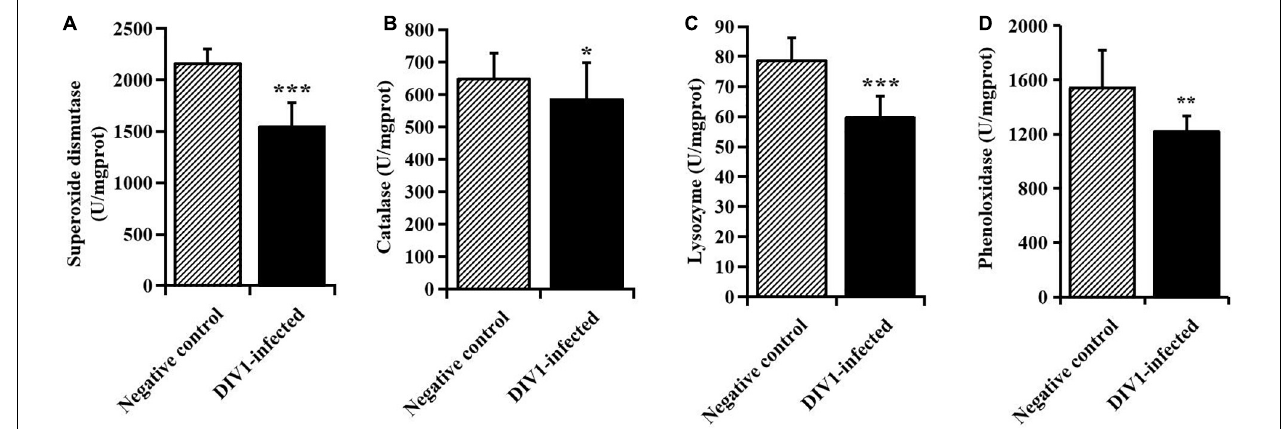
FIGURE 2 | The activities of immune enzymes in the plasma of Marsupenaeus japonicus (mean ± SD). (A) Superoxide dismutase, (B) catalase, (C) lysozyme, and (D) phenoloxidase (PO). The statistically significant differences between the two groups were calculated by Student’s t -test (* p < 0.05, ** p < 0.01, *** p < 0.001).